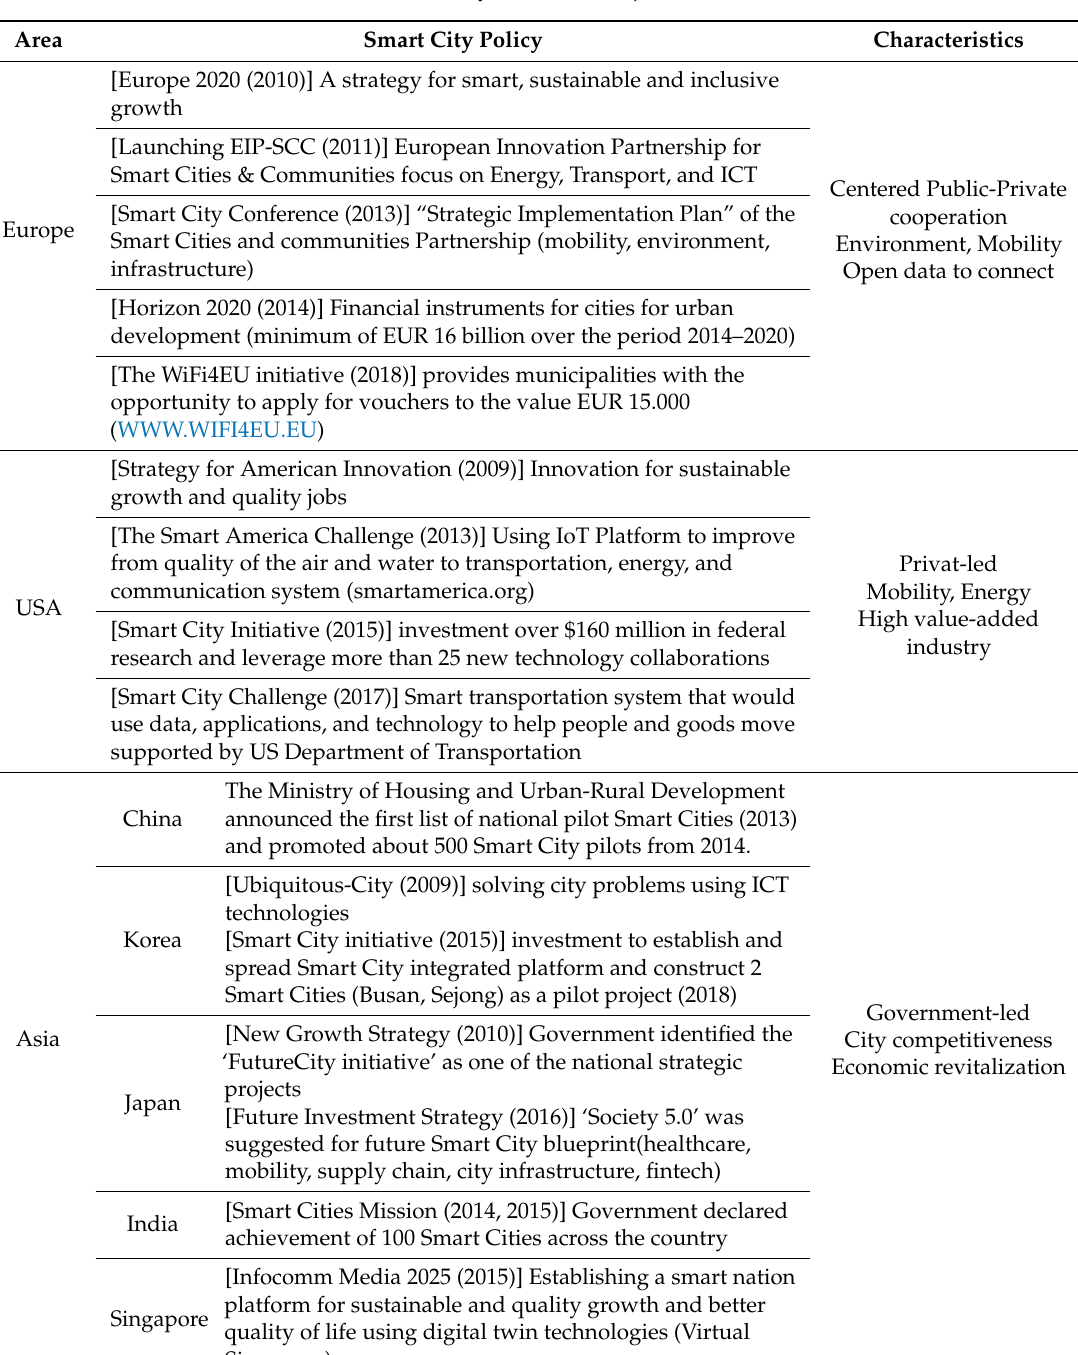
Table 1. Smart City Policies in Major